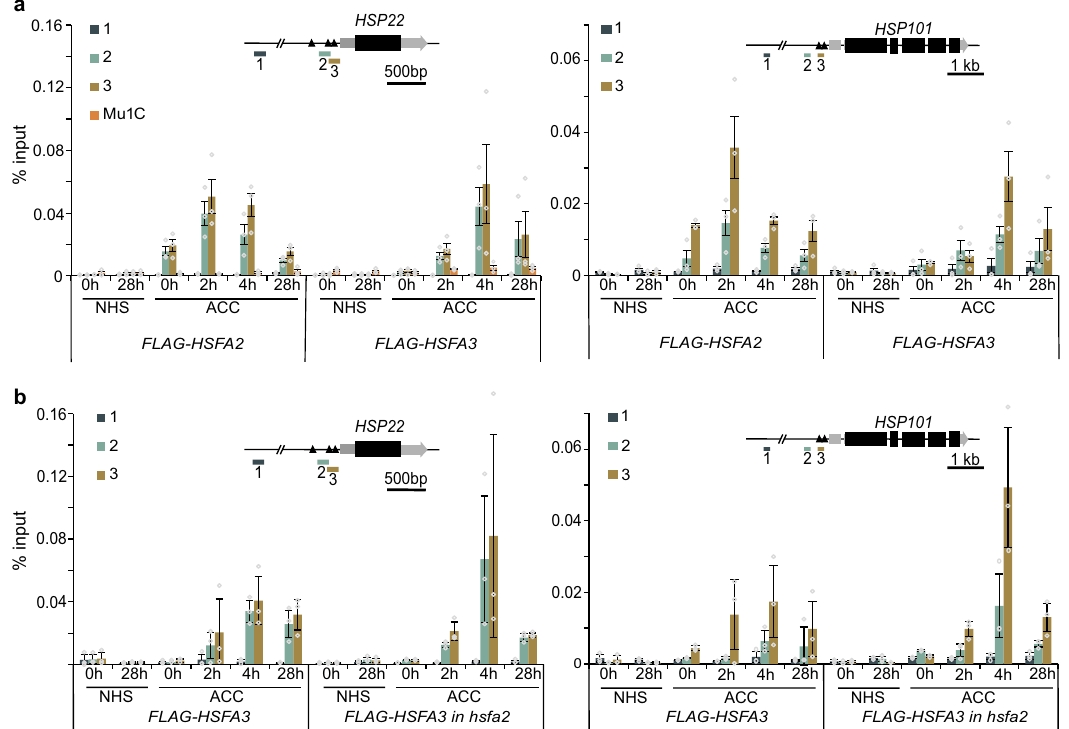
Fig. 8 HSFA2 and HSFA3 bind to memory gene promoters directly and independently. a Occupancy of HSFA2 and HSFA3 as determined by ChIP-qPCR from pHSFA2::FLAG-HSFA2 and pHSFA3::FLAG-HSFA3 . b Occupancy of HSFA3 as determined by ChIP-qPCR from pHSFA3::FLAG-HSFA3 in the wild type or hsfa2 mutant background. Enrichment normalized to Input (Data are mean ± SD) from three independent experiments is shown for the HS memory gene HSP22 and the non-memory gene HSP101 . The transposon Mu1c is shown as a non HS-responsive locus. Time points are given in h after end of ACC treatment. For each locus one control amplicon situated approximately 3 kb upstream is shown alongside the amplicon covering heat shock elements (black triangles) in the promoter (inset gene